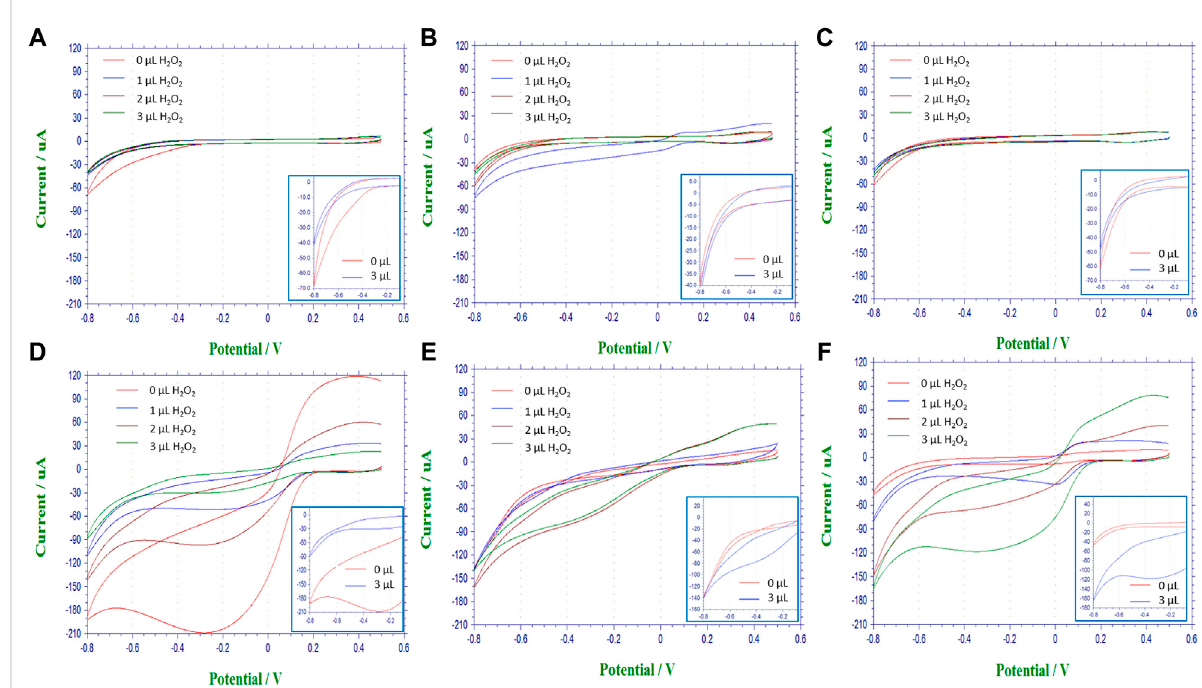
FIGURE 7 Voltammograms of nanocomposite biosensing fi lms performed with a voltage sweep between 0.5 V and − 0.8 V at a rate of 100 mV/s on controls and corresponding reactive catalase immobilized slabs in the top and bottom rows, respectively. (A) alginate slabs; (B) alginate slabs with CNTs(A/CNT); (C) alginateslabswithCNTsandchitosan(A/CNT/Chi); (D) alginateslabswithCAT(AE); (E) alginateslabswithCNTsandCAT(A/CNT+ E); (F) alginate slabs with CNTs, chitosan and CAT (A/CNT/Chi +